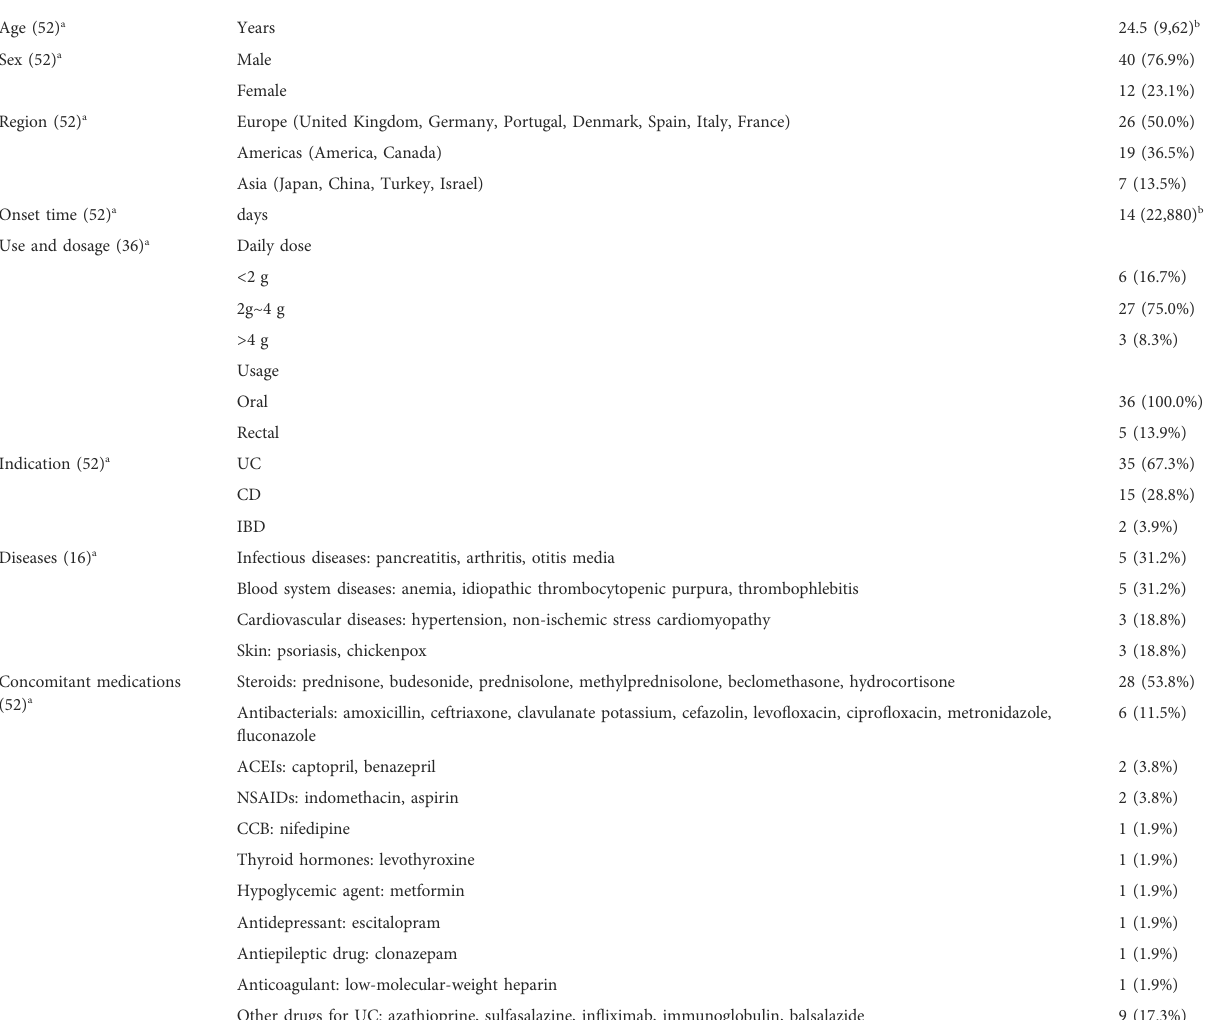
TABLE 1 General data of 52 patients reported in case series/reports.